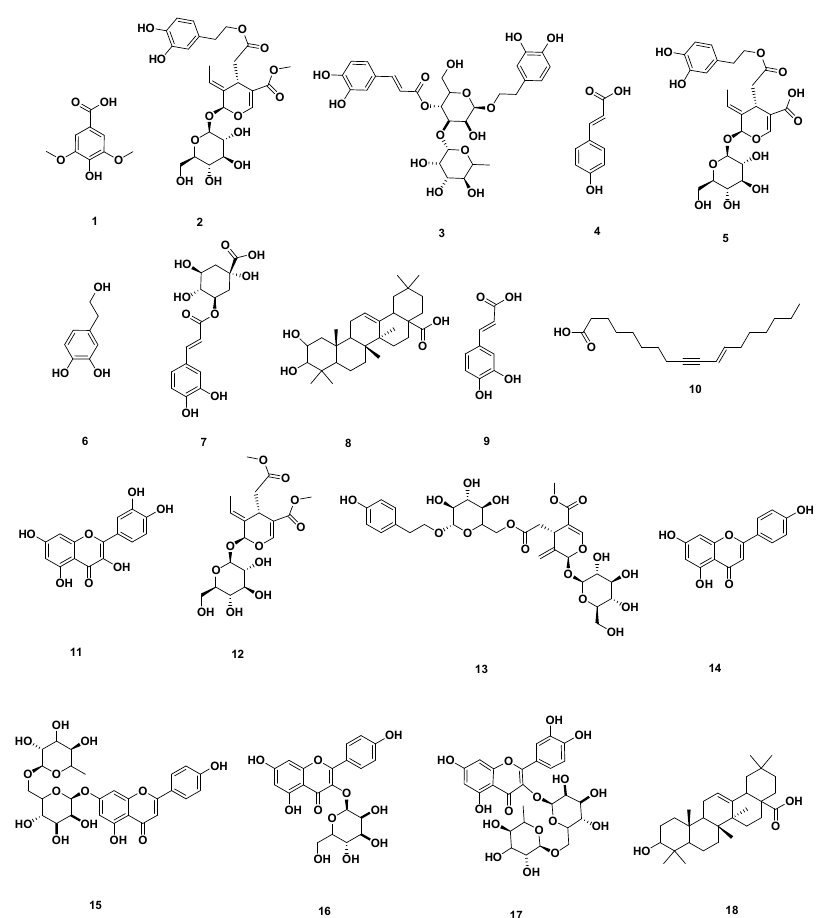
Figure 1. ( A ) LC-HRESIMS chromatogram of the dereplicated metabolites of Olea europaea L. cv. Picual (positive); ( B ) LC-HRESIMS chromatogram of the dereplicated metabolites of Olea europaea L. cv. Picual (negative).